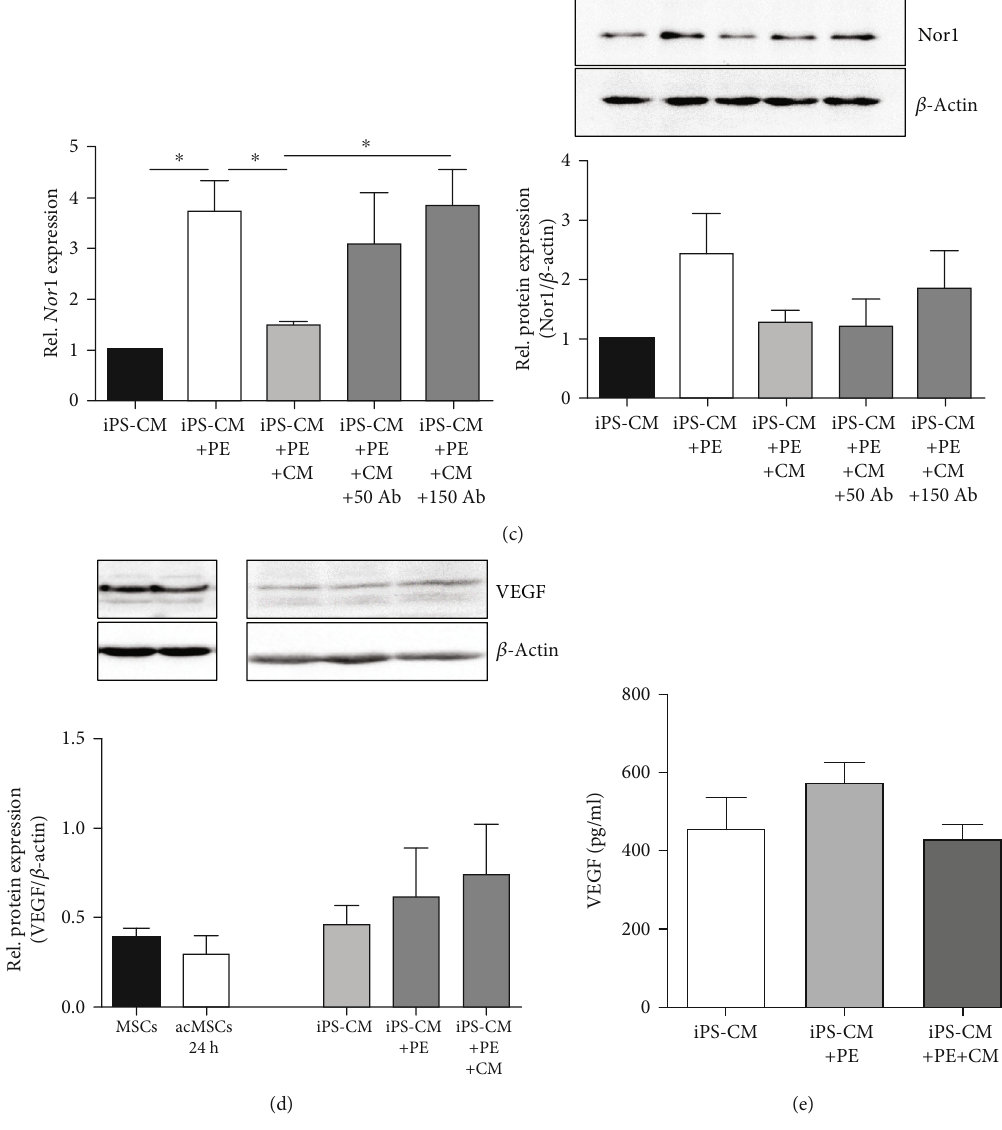
Figure 6: MSC-derived VEGF is essential for hypertrophy regression in iPS-CM. (a) VEGF was quanti fi ed in culture supernatants of MSCs stimulated with 30ng/ml IFN- γ and 3ng/ml IL-1 β for 24h and those cultured for additional 24 h in serum-free medium (48 h). In addition, VEGF levels in fractionated MSC-conditioned medium (concentrates and fi ltrates) were determined by ELISA. n = 5 . (b) PE-treated hypertrophied iPS-CM were cultured in the presence of 20% MSC-conditioned medium (CM) for 24h. As a control, cells were cultured in medium supplemented with > 30kDa concentrates. For VEGF neutralization, 50ng/ml or 150ng/ml neutralizing anti-VEGF antibodies was added to the culture medium. The cell surface area was quanti fi ed by F-actin staining. Representative images are displayed. Bar: 100 μ m. n = 5 . (c) Nor1 gene and protein expression was quanti fi ed in iPS-CM cultured in the presence of MSC-CM supplemented with VEGF-neutralizing antibodies. n = 4 . (d) Intracellular VEGF levels were quanti fi ed in hypertrophied iPS-CM cultured in the presence of 20% CM for 24h. MSCs with and without preconditioning served as a control. n = 4 . (e) VEGF levels were quanti fi ed in culture supernatants of PE-treated iPS-CM cultured in medium supplemented with 20% CM for 24h. n = 6 . ∗ p < 0 : 05 , ∗∗ p < 0 : 01 , and ∗∗∗ p < 0 : 001